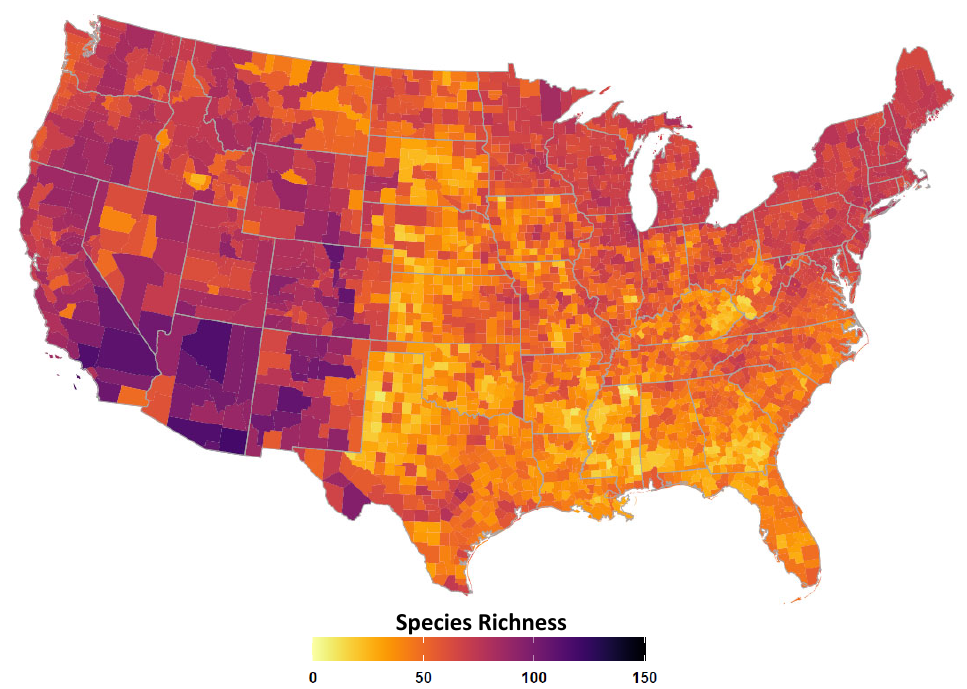
Figure A5. Static avian host species richness. Species richness covariate under assumption of a static species pool (May–August). Map is color coded according to legend at bottom with darker tones indicating higher species